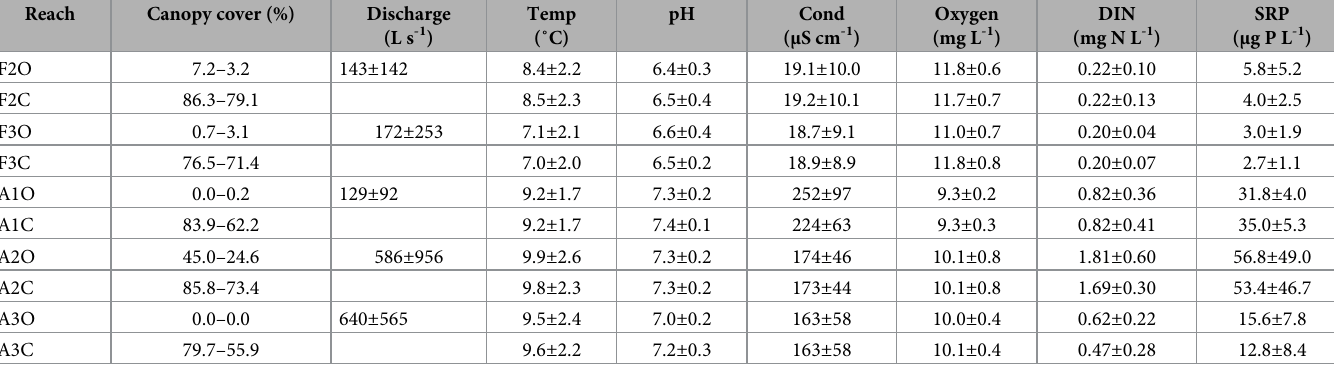
Table 2. Environmental characteristics of the study reaches. F stands for forest, A for agricultural, O for Open, C for Closed. Canopy cover values are point values mea- sured at the beginning and at the end of the experiment. The rest of the values are mean ± SD of 5 measurements during the experiment. DIN (dissolved inorganic nitro- gen) is the sum of nitrate-, nitrite- and ammonium-nitrogen. SRP, soluble reactive phosphorus. Discharge was only measured in one site per stream, where it was most convenient, not necessarily in any of the sampling reaches. Reach Canopy cover